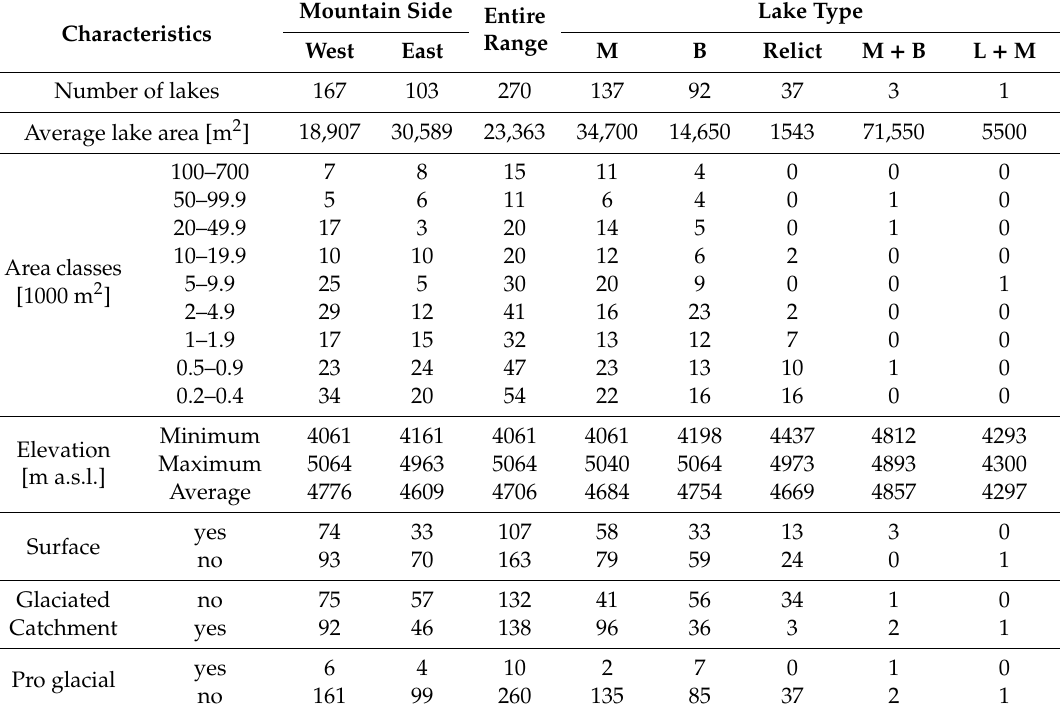
Table 3. Characteristics of the 270 lakes of the Cordillera